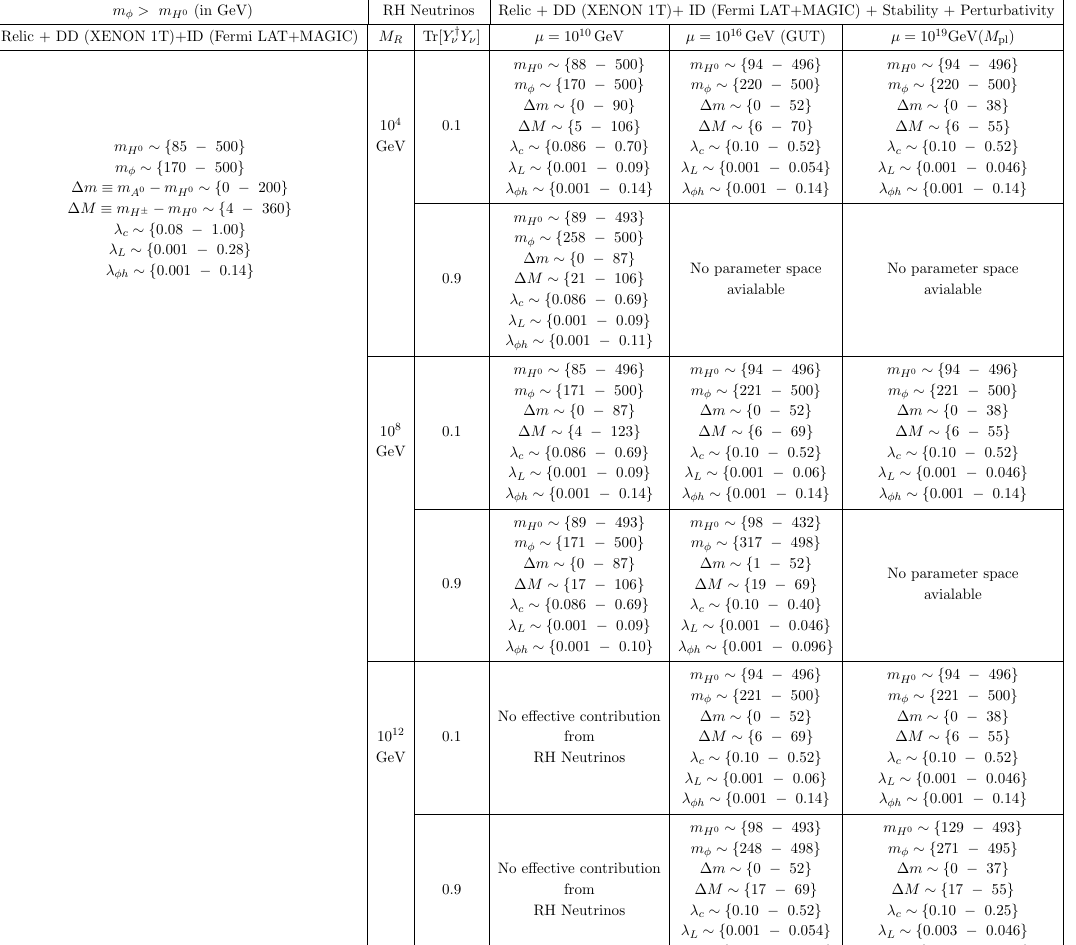
for di(cid:11)erent values of RH H 0